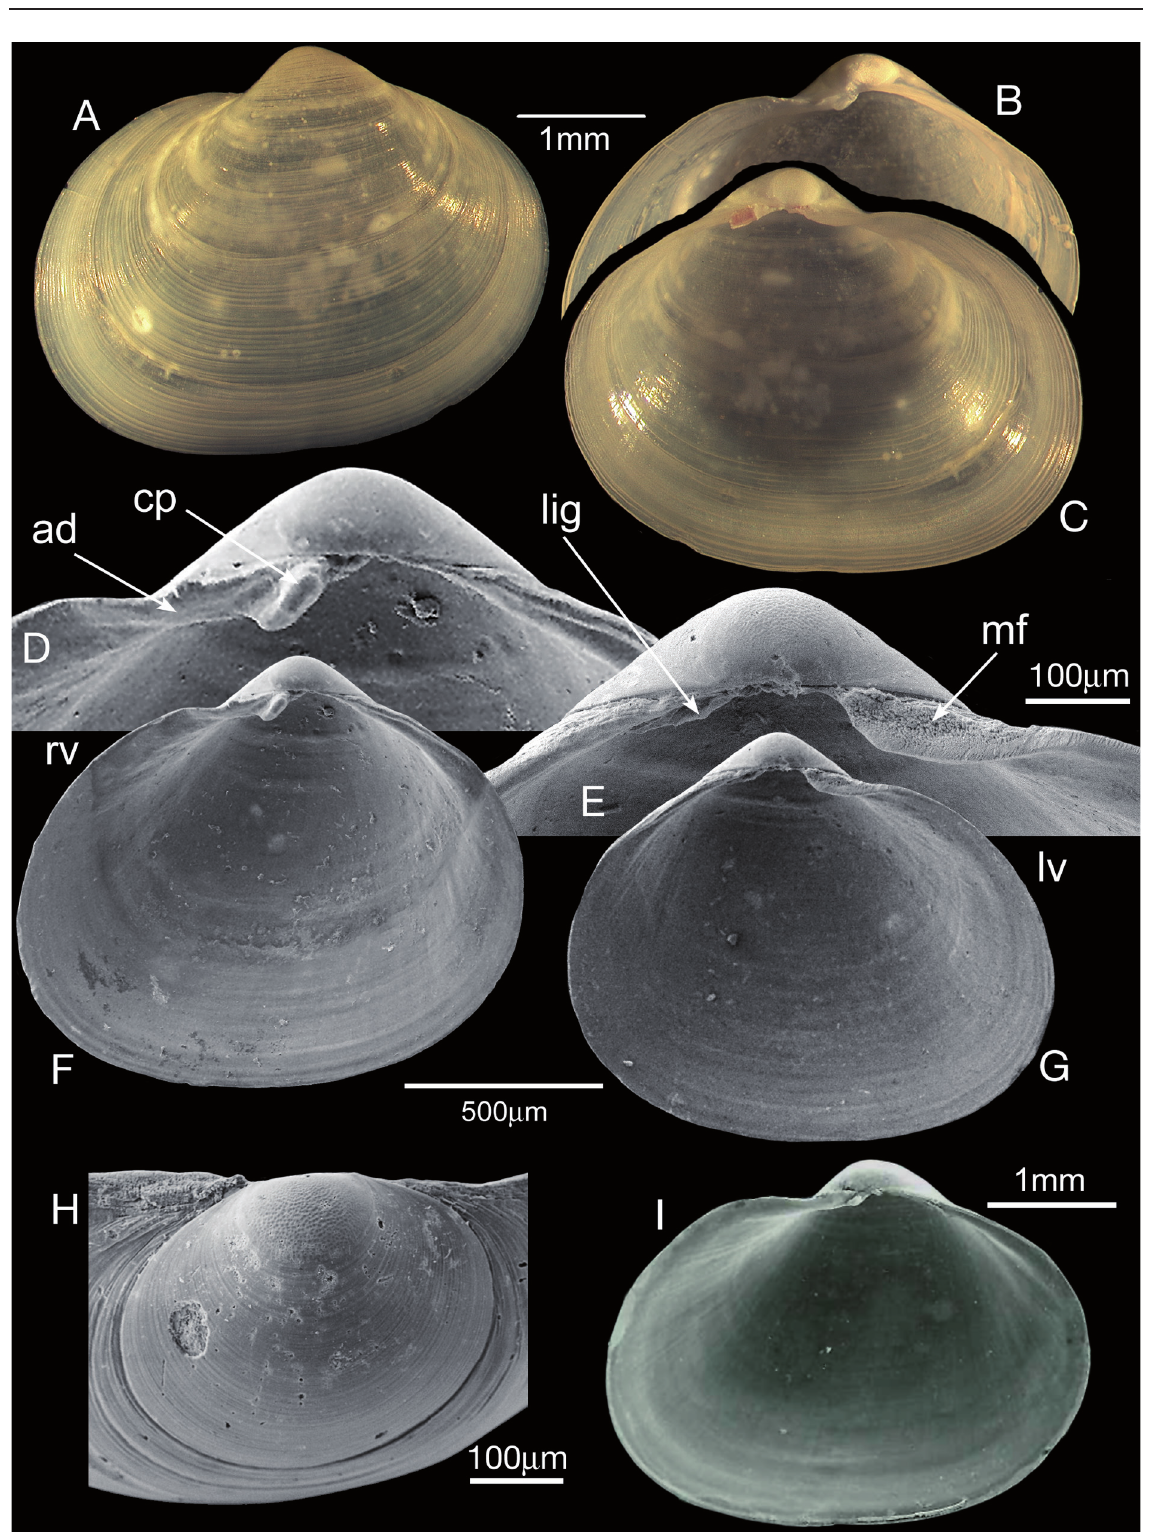
Fig. 7. Syssitomya pourtalesiana sp. nov. from Norwegian Sea. A-C . Photo micrographs a external of left valve, internals of both valves. D-E . SEM of hinges of right and left valves. F-G . SEM of internal of both valves. H . SEM of prodissoconch. I . SEM of internal of right valve from NORBI cruise, abyssal, Courtesy of Anders